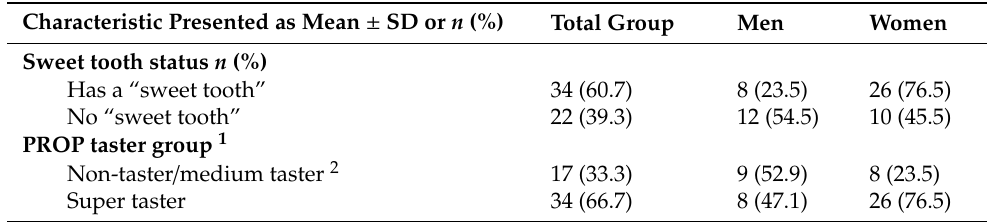
Table 3. Sweet tooth and 6- n -propylthiouracil (PROP) taster status. Characteristic Presented as Mean ± SD or n (%)